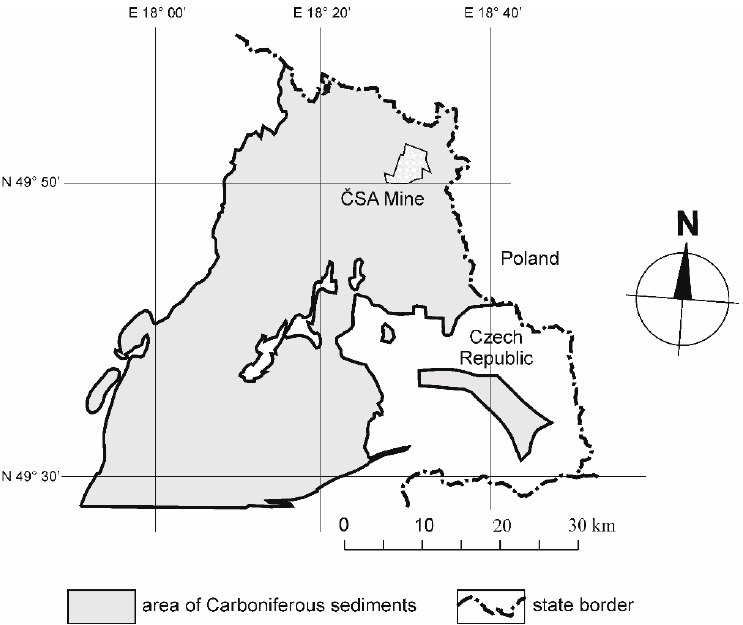
Figure 1. Schematic map of the Czech part of the Upper Silesian Basin showing the area of the Č SA Mine, where the investigated Ra-rich baryte comes from.